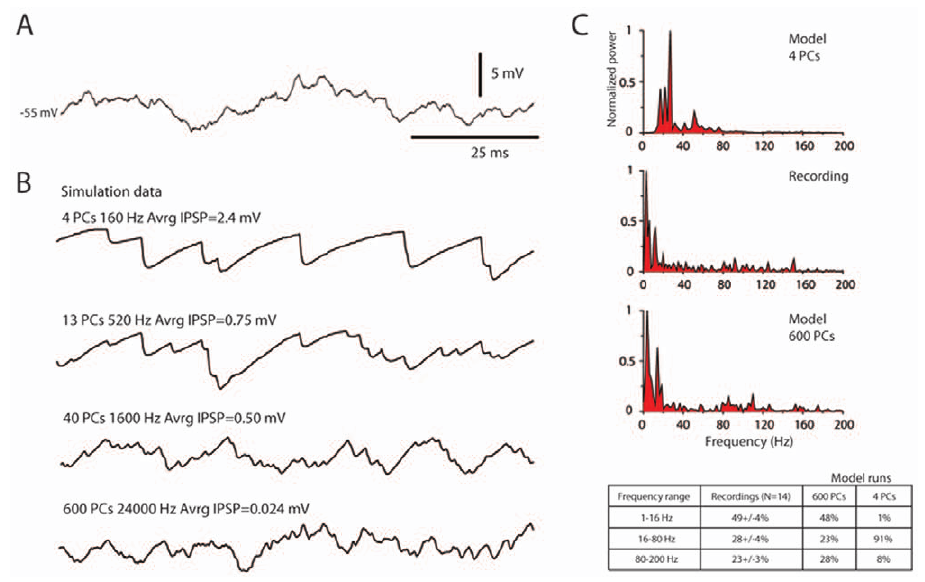
Figure 3. Non-synchronized, high frequency IPSP inputs generate smooth baseline. (A) Close-up of raw data. (B) Simulated data for varying number of PC inputs. The number of PCs, the average IPSP frequency and the average IPSP amplitude is indicated for each simulation run. (C) Power spectral density analysis for recorded signal and simulated signal with low and high number of PC inputs, respectively. Numerical comparisons were made for the relative power in different frequency intervals (inset table).